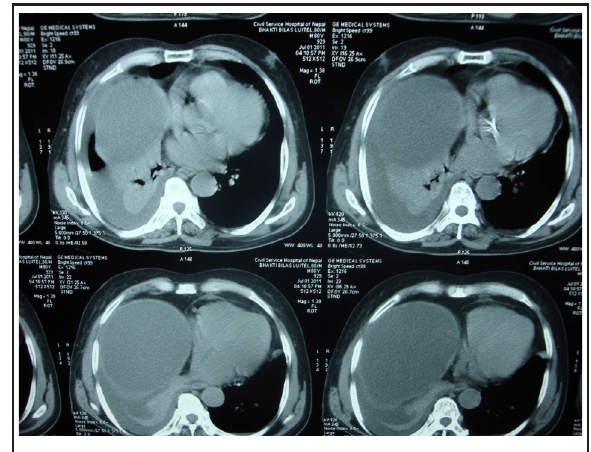
Figure 1. Computerized tomogram of upper abdomen showing a large subcapsular collection along with mild ascites and right sided pleural effusion.